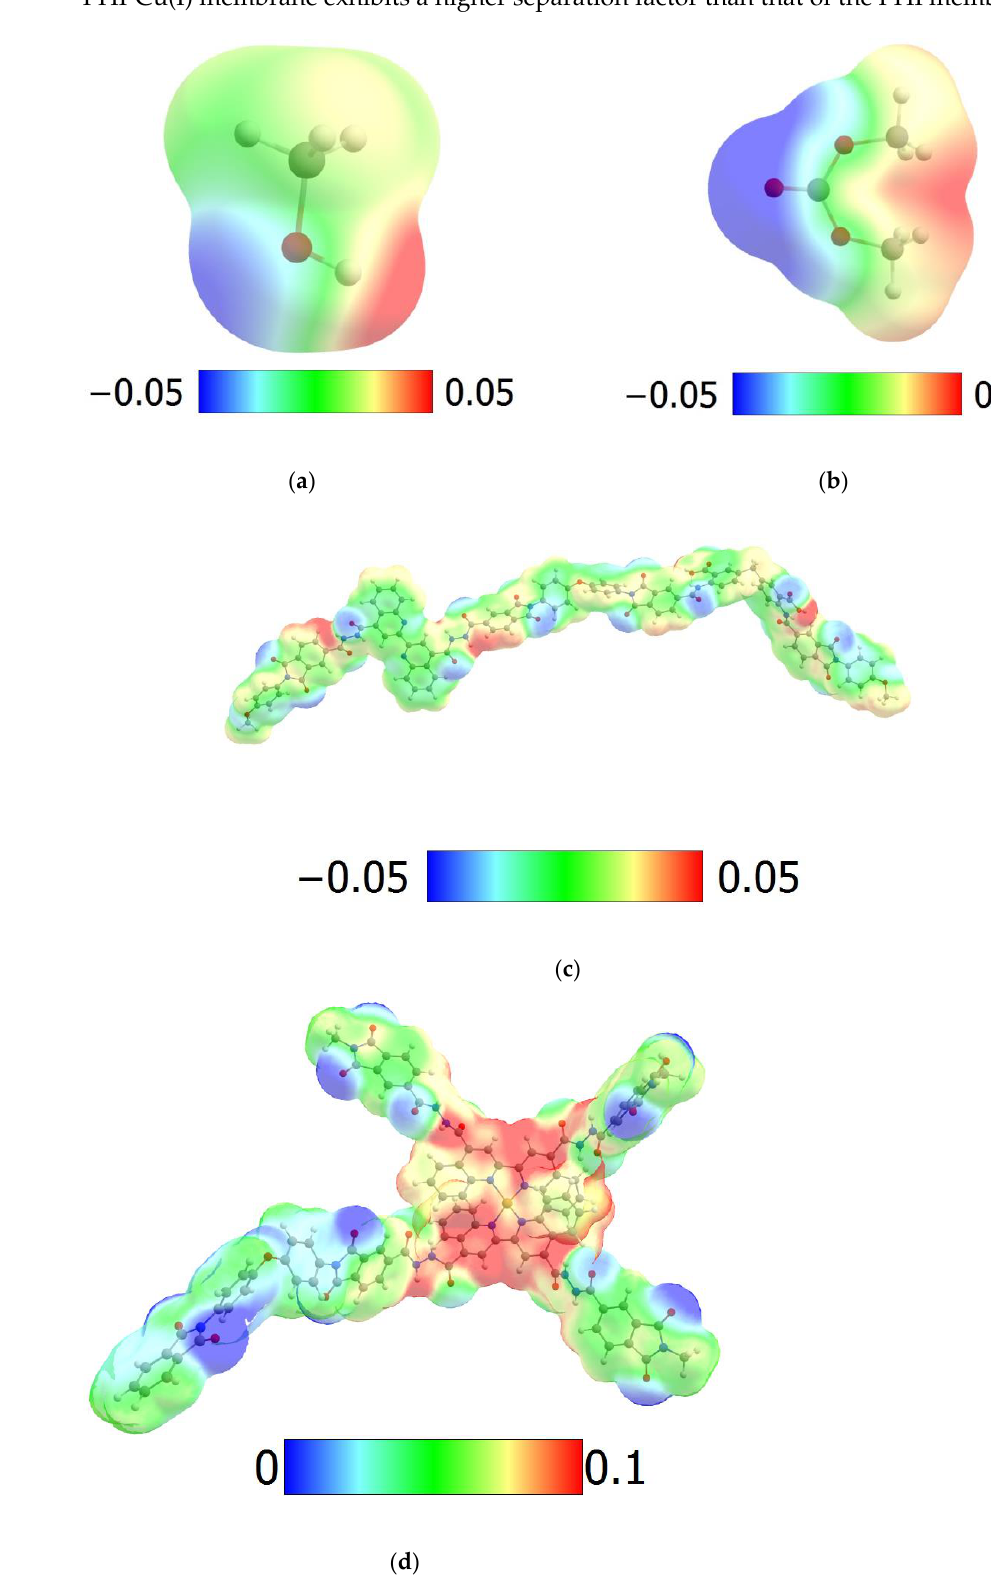
Figure 7. MEP maps for MeOH ( a ), DMC ( b ), dimer ( c ), and Cu-complex with two monomer units ( d ). Contour value: 0.001. Values range: − 0.05–0.05 ( a – c ), 0–0.1 ( d ).